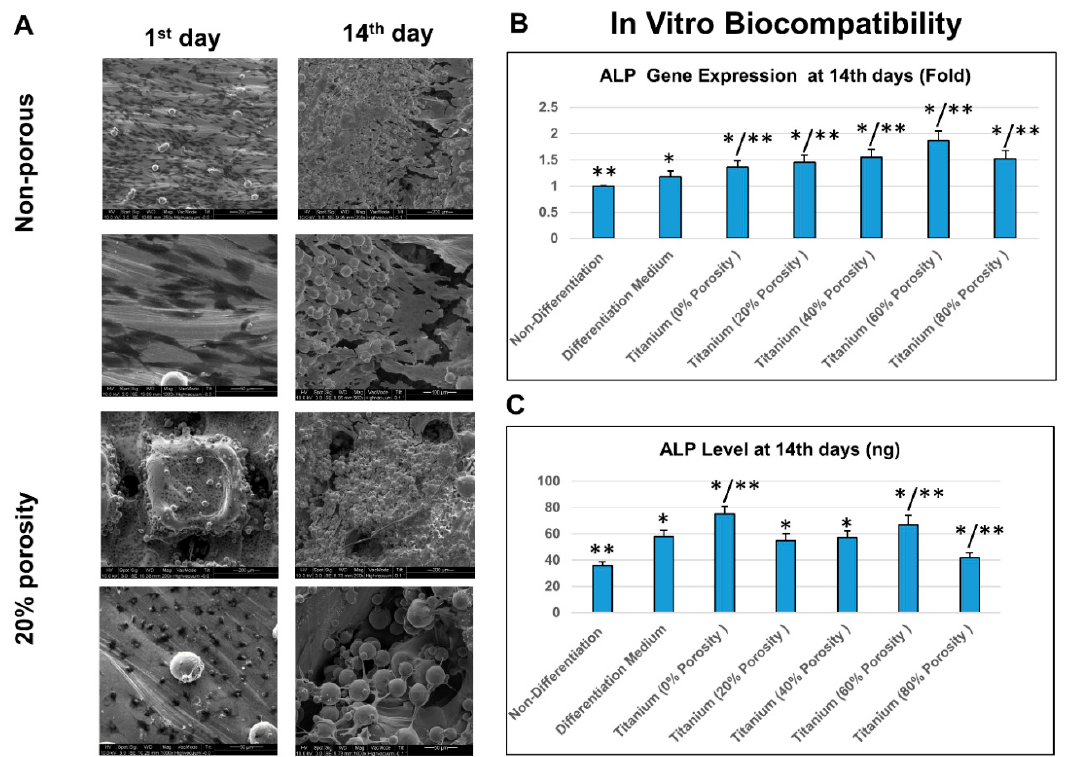
Figure 4. MG63 cells differentiation on DMLS Ti 6 Al 4 V discs: in vitro biocompatibility analysis. ( A ) MG63 cells attached, proliferated and differentiated well on both non-porous and porous DMLS Ti 6 Al 4 V discs. The MG63 cell clusters attached on the surface of discs and grew into the pores. Representative results of 10 independent experiments are shown. (Length of scale bar: as described) ( B ) Comparisons of alkaline phosphatase (ALP) mRNA gene expressions or ( C ) relative ALP activity after 14 days of culturing MG63 cells in control medium (non-differentiation), osteogenic (differentiation) medium, or on Ti 6 Al 4 V discs of various (0, 20, 40, 60 or 80%) porosities (n = 10). The